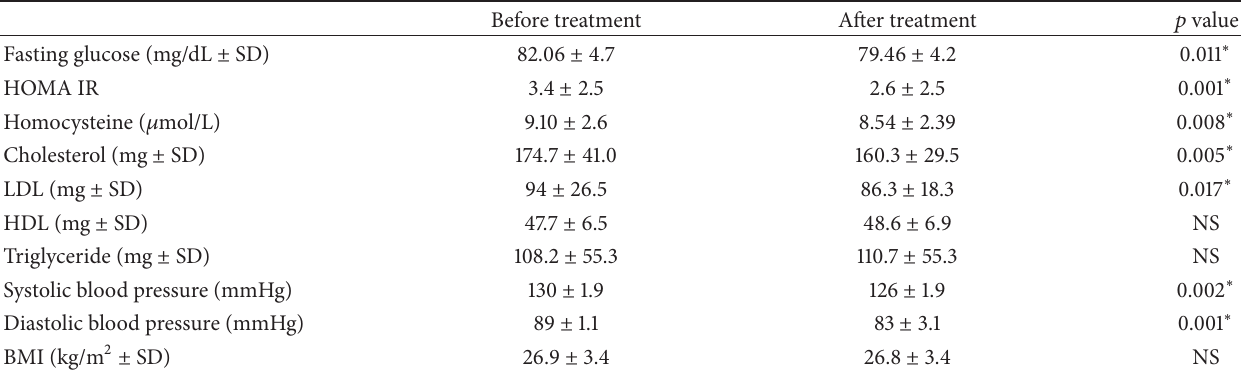
Table 1: Patients’ characteristics and outcomes data. Before